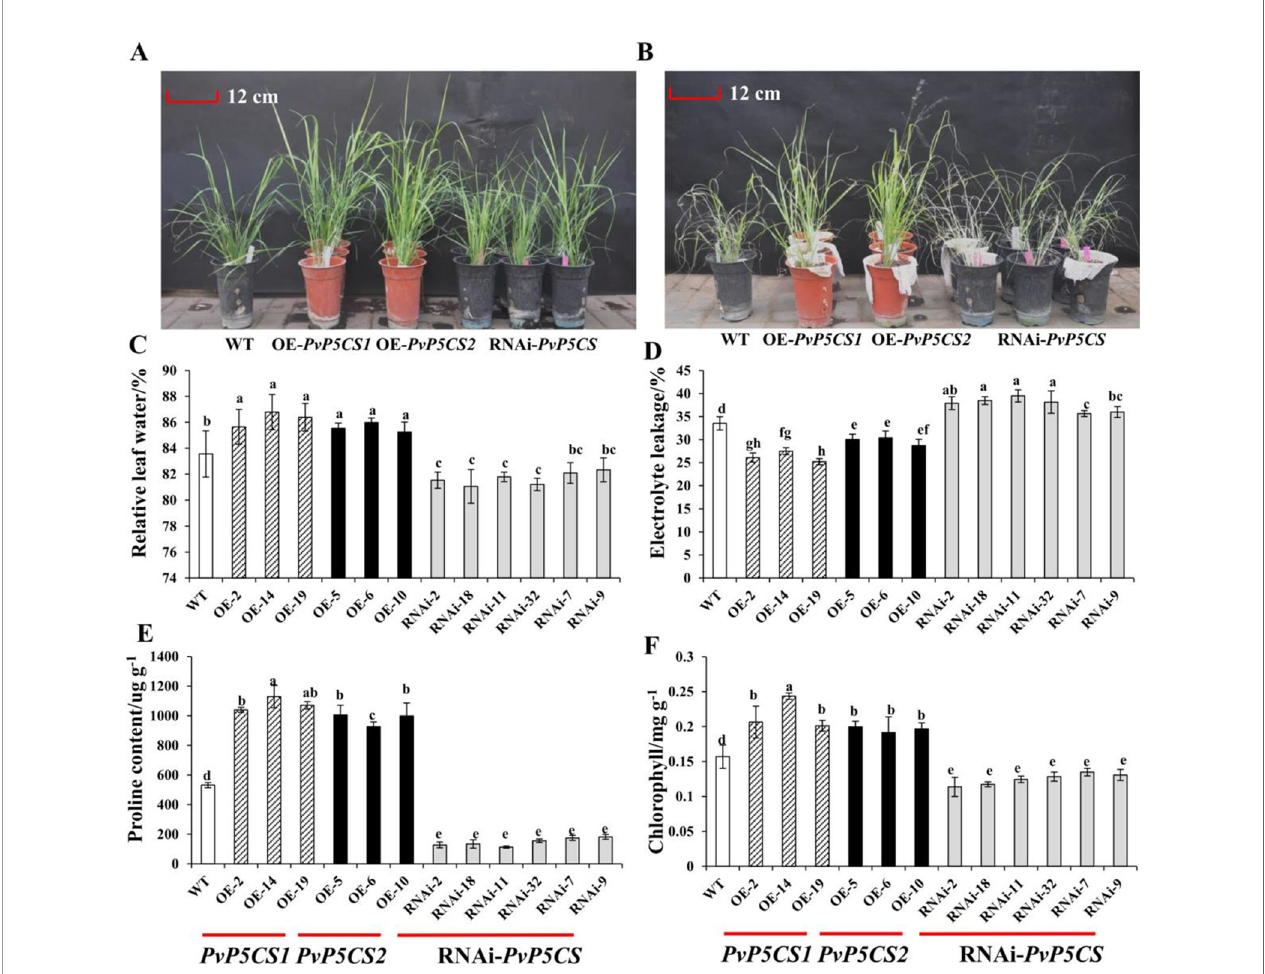
FIGURE 4 | The salt tolerant evaluation of PvP5CS OE and RNAi transgenic plants under salt treatment. Phenotypes of PvP5CS OE and RNAi transgenic plants under 0 mM NaCl (A) and 350 mM NaCl (B) treatment for 15 days. Relative leaf water content (C) , Electrolyte leakage (D) , proline (E) and Chlorophyll (F) of transgenic lines OE- PvP5CS1 , OE- PvP5CS2 and RNAi- PvP5CS in (B) after 350 mM NaCl treatment for 15 days. Data are mean values of three biological repeat, and signi fi cance of treatments was tested at the P < 0.05 level (one way ANOVA, Dunnett's